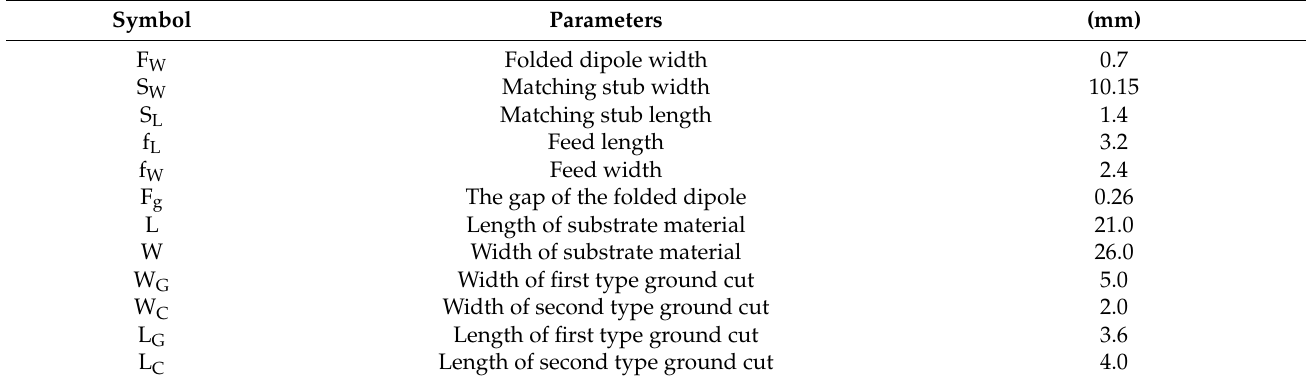
( b ) Figure 3. ( a ). Top view of the antenna (N) showing the patch array structure of the antenna, ( b ) bottom view of the antenna showing the ground plane with the first set of three cuts. To further improve the performance of the designed antenna N, in the next stage an additional three slots are etched to the ground part. This modified antenna is now termed antenna O. The representation of this antenna structure is shown in Figure 4a,b. The slots are now of a 2 × 3 array form. The new row of slots formed consists of two cuts of dimen- sions W G × L C and one cut of dimensions W C × L C . The last cut that lies close to the bound- ary of the ground is slightly misaligned to the cut made in the previous stage for obtaining a proper response. This modification allows the antenna to operate at dual-band i.e., at 22.6 and 35.05 GHz, with a lower reflection coefficient value at both the bands.